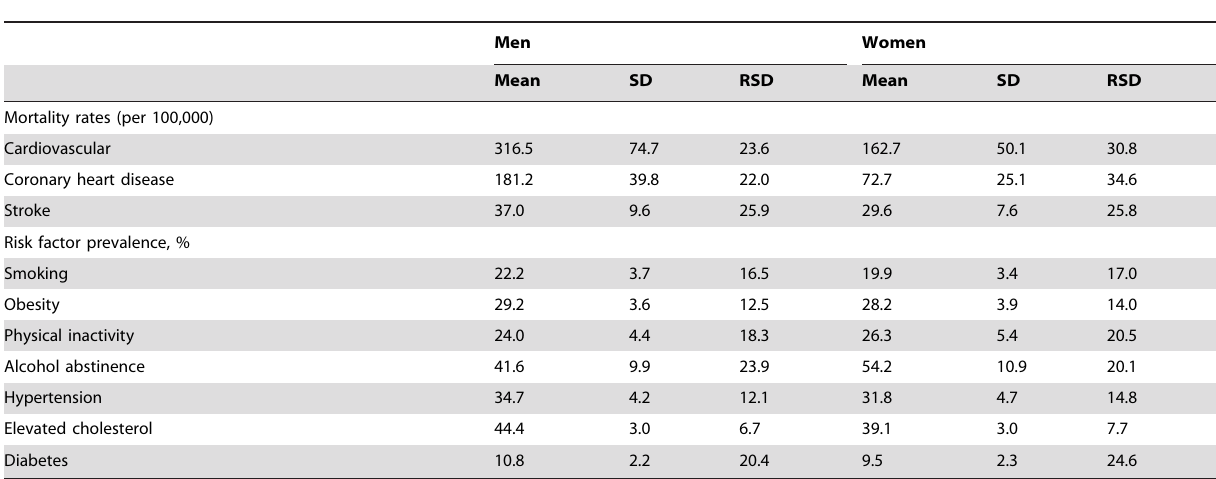
Table 1. State-level CV risk index and risk factor prevalence for adults aged 40–69 y in 2005 and mortality rates aged 45–74 y in 2010 in the 50 US states and